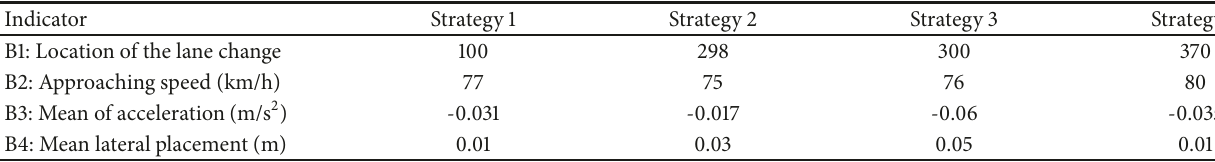
Table 7: Vectors (cid:2) 󸀠